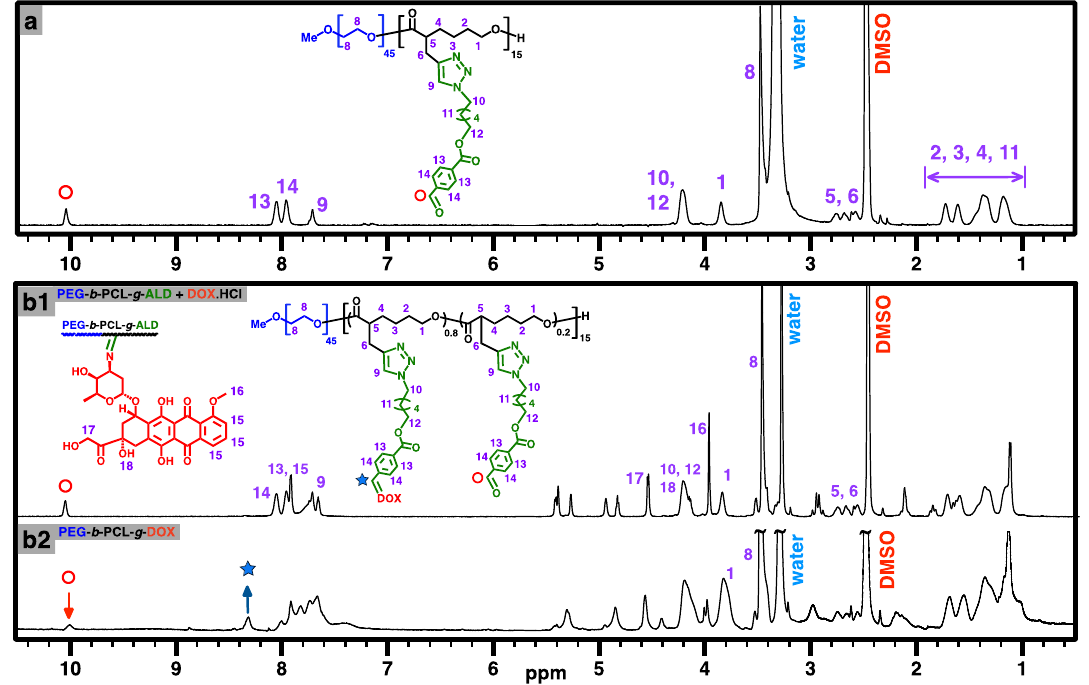
Figure 3. 500 MHz 1 H NMR spectra: ( a ) PEG- b -PCL- g -ALD ( 4 ), ( b1 ) mixture of PEG- b -PCL- g -ALD and DOX.HCl, and ( b2 ) PEG- b -PCL- g -DOX ( 5 ) in DMSO-D